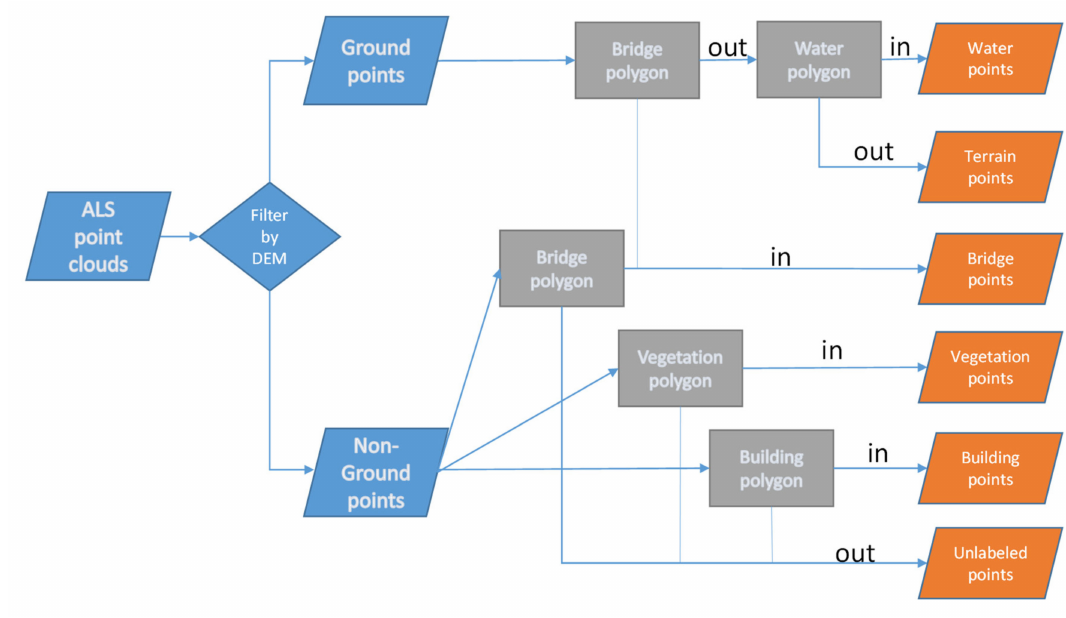
Figure 1. Workflow for the point-in-polygon